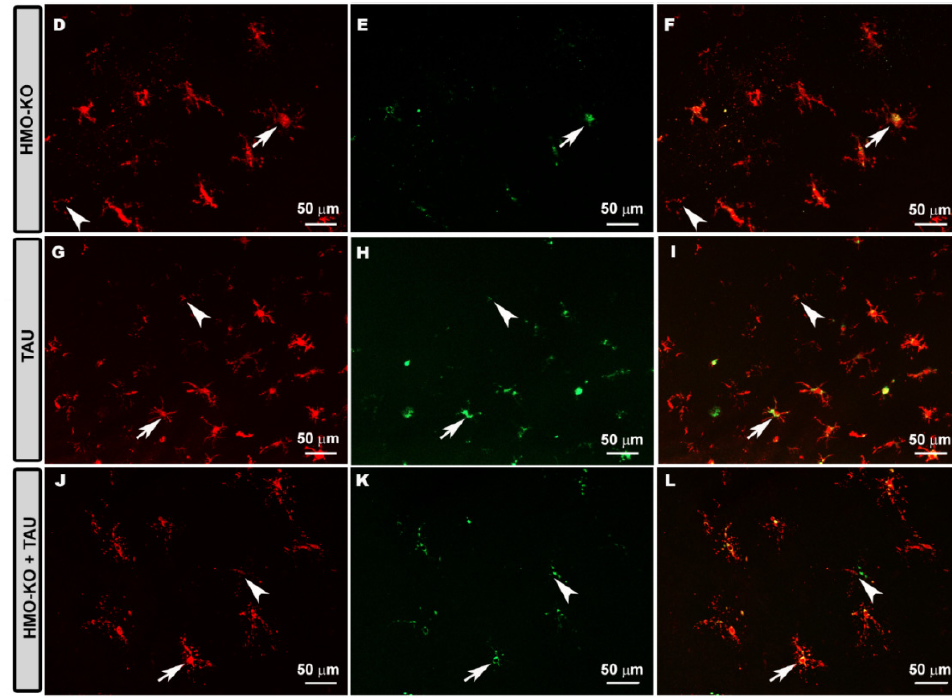
Figure 2. Retinal wholemount. Double immunolabeling with anti-Iba-1 (red) and anti-CD68 (green) in OS layer in the different study groups: WT ( A – C ), HMO-KO ( D – F ), TAU ( G – I ), HMO-KO+TAU ( J – L ); 20 × magnification. Microglia with CD68+ labelling (arrows). Dystrophic microglia (arrow- heads). The images correspond to the retinal periphery. Number of retinas used in the experiment: WT n = 6, HMO-KO n = 6, TAU n = 6, and HMO-KO+TAU n = 6.